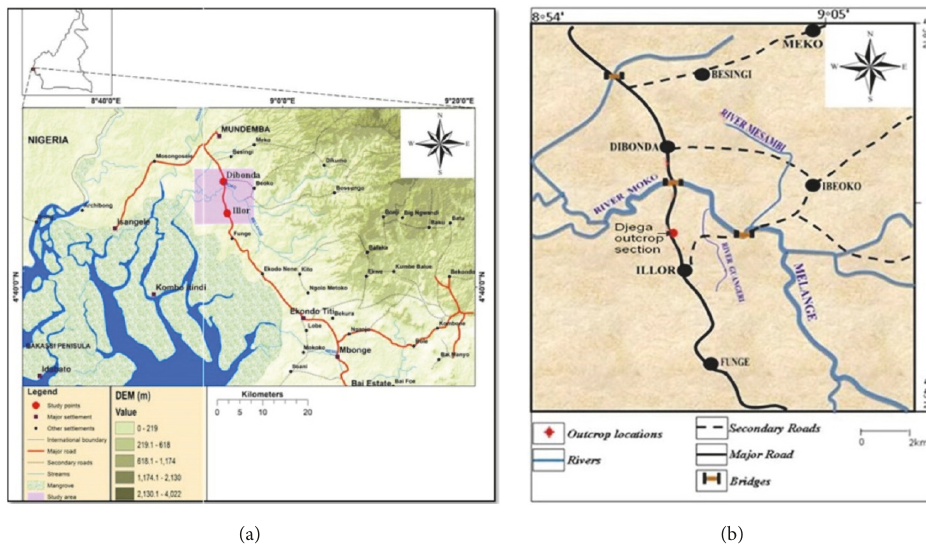
Figure 2: Map of the Rio del Rey Basin indicating the Illor-Dibonda area in the northern part of the basin.